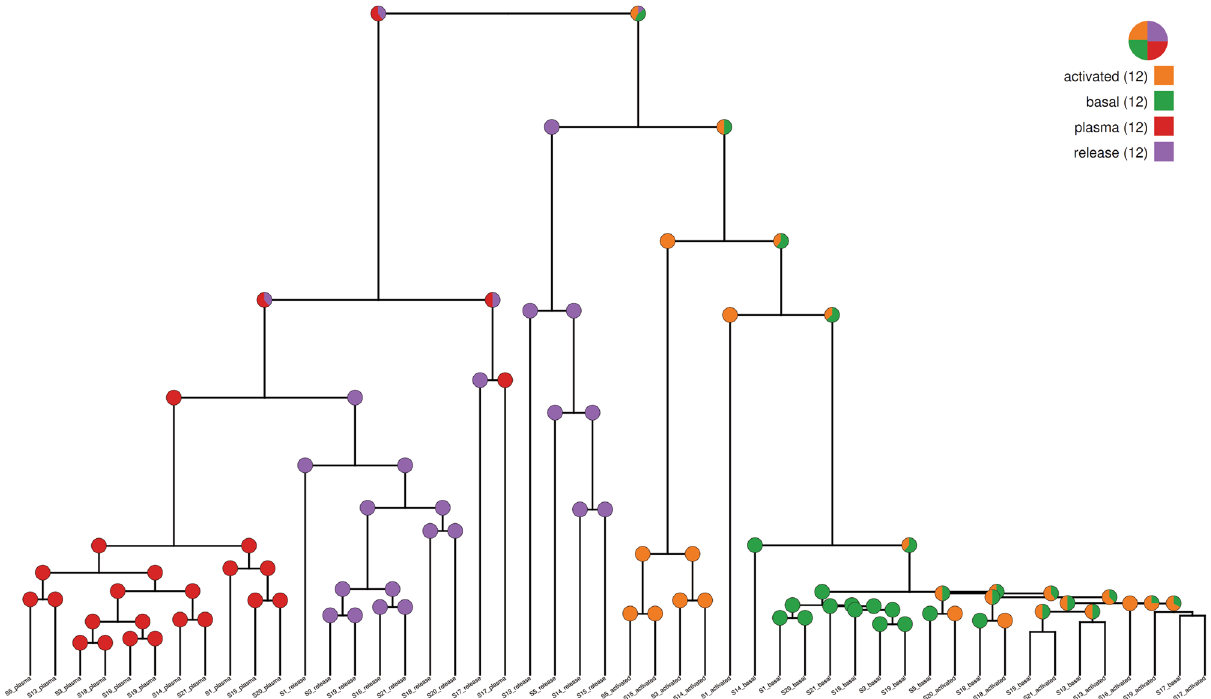
Figure 5. Comparisons of platelet lipidomes with their release and plasma. We pairwisely compared the lipid chemical structures to achieve a numerical positive distance value between each pair of lipids. Having a list with n lipids, we obtained an n times n matrix which was visualized by a principal component analysis considering the lipid quantities. Number of biological replicates n =